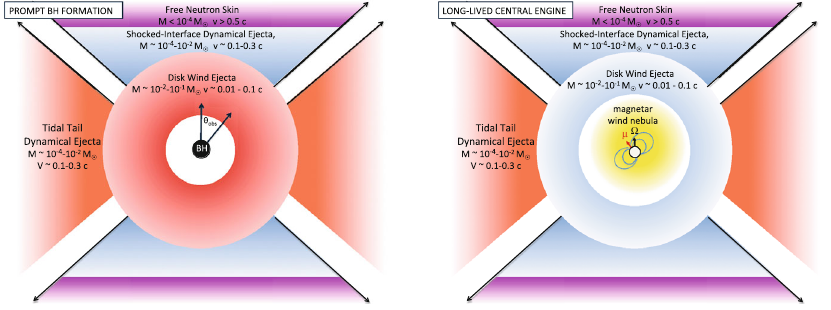
Fig. 3 Different components of the ejecta from NS–NS mergers and the dependence of their kilonova emission on the observer viewing angle, θ obs , relative to the binary axis, in the case of prompt BH forma- tion ( top panel ) and a long-lived magnetar remnant ( bottom panel ). In both cases, the dynamical ejecta in the equatorial plane is highly neutron-rich ( Y e (cid:2) 0 . 1), producing lanthanides and correspondingly “ red ” kilonova emission peaking at NIR wavelengths. Mass ejected dynamically in the polar directions by shock heating may be sufficiently neutron-poor ( Y e (cid:3) 0 . 3; Wanajo et al. 2014b) to preclude Lanthanide produc- tion, instead powering “ blue ” kilonova emission at optical wavelengths (although this component may be suppressed if BH formation is extremely prompt). The outermost layers of the polar ejecta may contain free neutrons, the decay of which powers a UV transient lasting a few hours following the merger (Sect. 4.1.3). The innermost layers of the ejecta originate from accretion disk outflows, which are likely to emerge more isotropically. When BH formation is prompt, this matter is also mainly neutron-rich, powering red kilonova emission (Just et al. 2015; Wu et al. 2016). If the remnant is instead long-lived, then neutrinos from the NS remnant can increase the electron fraction of the disk outflows to suppress Lanthanide production and result in blue disk wind emission (Metzger and Fernández 2014; Perego et al. 2014; Martin et al. 2015). Energy input from the central accreting BH ( top panel ) or magnetar remnant ( bottom panel ) enhance the kilonova luminosity compared to the purely radioactive-powered case (Sect.